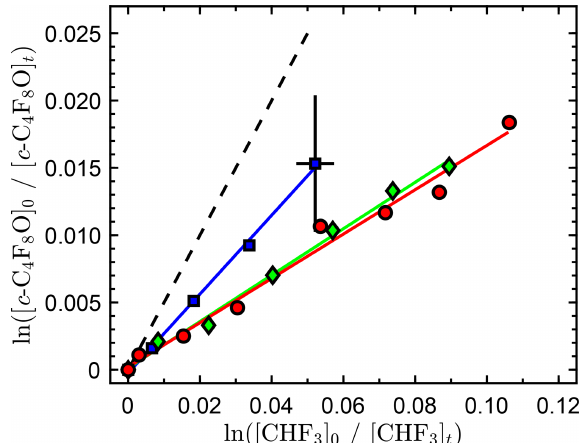
Figure 3. Relative rate data obtained in this work for the O ( 1 D ) + c - C 4 F 8 O reaction at 296K. The different symbols are results from independent experiments, and the solid lines are linear least-square fits to the data of the individual experiments. Representative esti- mated error bars from the infrared spectral analysis are included only on a single data point for improved clarity of the graph. The dashed line represents the upper-limit rate coefficient ratio recom- mended in this